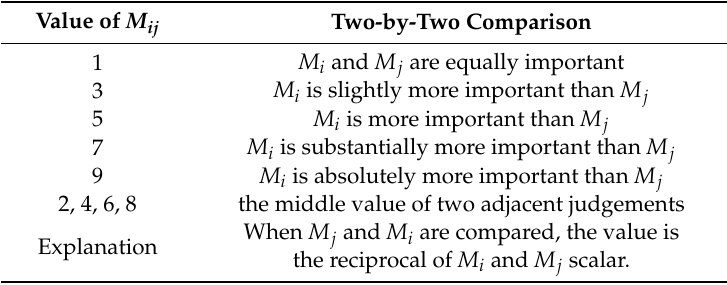
Table 2. The 1~9 scale method of analytic hierarchy process (AHP).